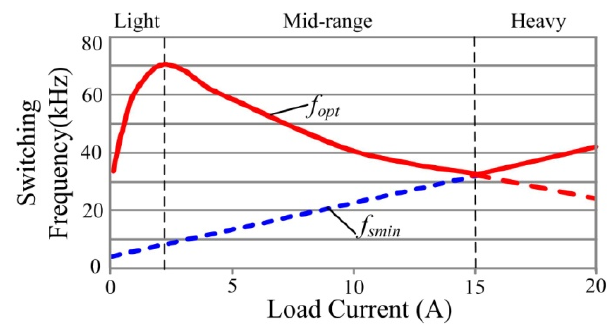
Figure 15. Optimum switching frequency at different load